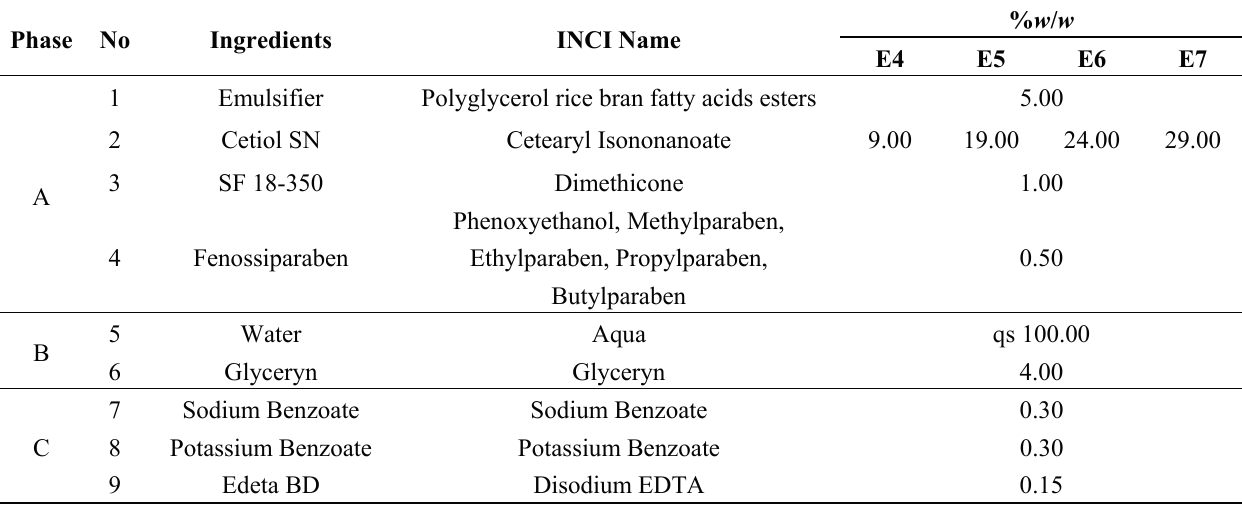
Table 2. Composition of O/W basic emulsions containing a different percentage of oil